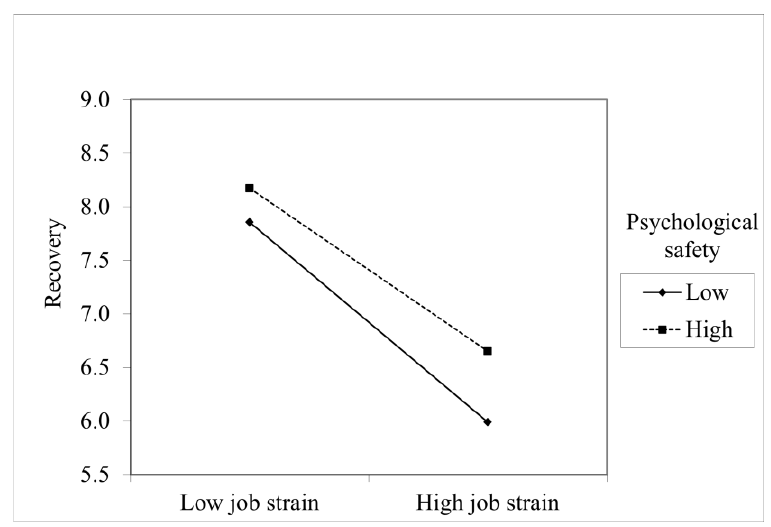
Figure 2. Psychological safety moderates the effects of job strain.